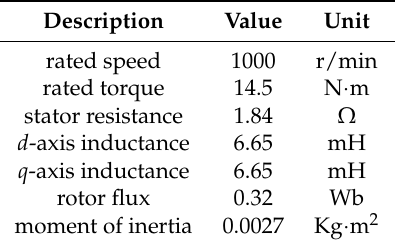
Table 1. Parameters of PMSM.